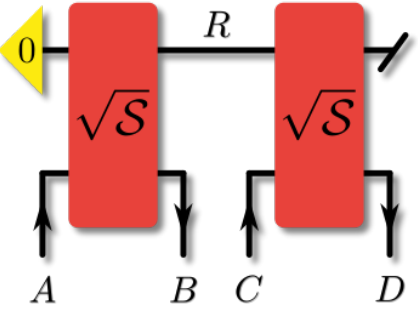
Figure 11: Circuit that leads to a four-partite GME comb. Note that using a Swap (cid:112) S would not yield a GME comb (see App. gate instead of